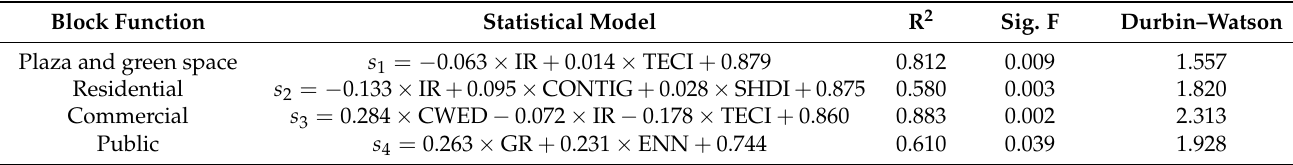
Table 3. Statistical correlation models for different functional